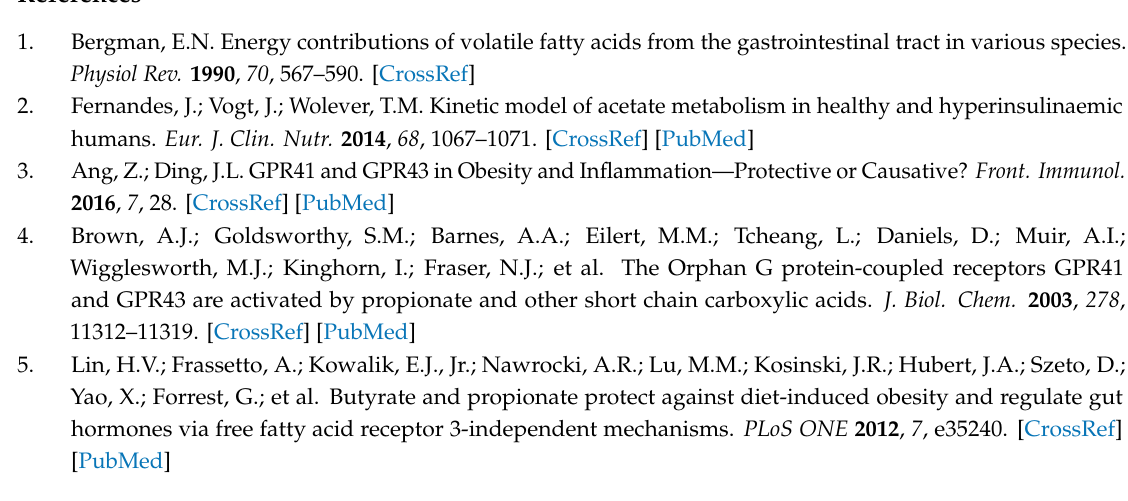
Figure S1: Correlations between other SCFAs across time points. T0-baseline, T1-week 12, T2-week 24, T3-week 50, Figure S2: ( a ) Changes in acetate according to weight loss quartiles; ( b ) Changes in propionate according to weight loss quartiles; ( c ) Changes in butyrate according to weight loss quartiles, Table S1: Baseline Characteristics, Blood-Based Biomarkers and SCFA Concentrations of Participants according to Treatment Group, Table S2: E ff ects of Weight Loss on Plasma SCFA Concentrations between Study Arms, Table S3: Summary of Multiple Regression Analysis for Variables Predicting Acetate. Concentrations at week 12, 24 and 50, Table S4: Summary of Multiple Regression Analysis for Variables Predicting Propionate Concentrations at Week 12, 24 and 50, Table S5: Summary of Multiple Regression Analysis for Variables Predicting Butyrate Concentrations at Week 12, 24 and 50, Table S6: Reported Energy and Macronutrient Intake at Baseline, and Reported Relative Changes Across Quartiles over Time at Week 12 and